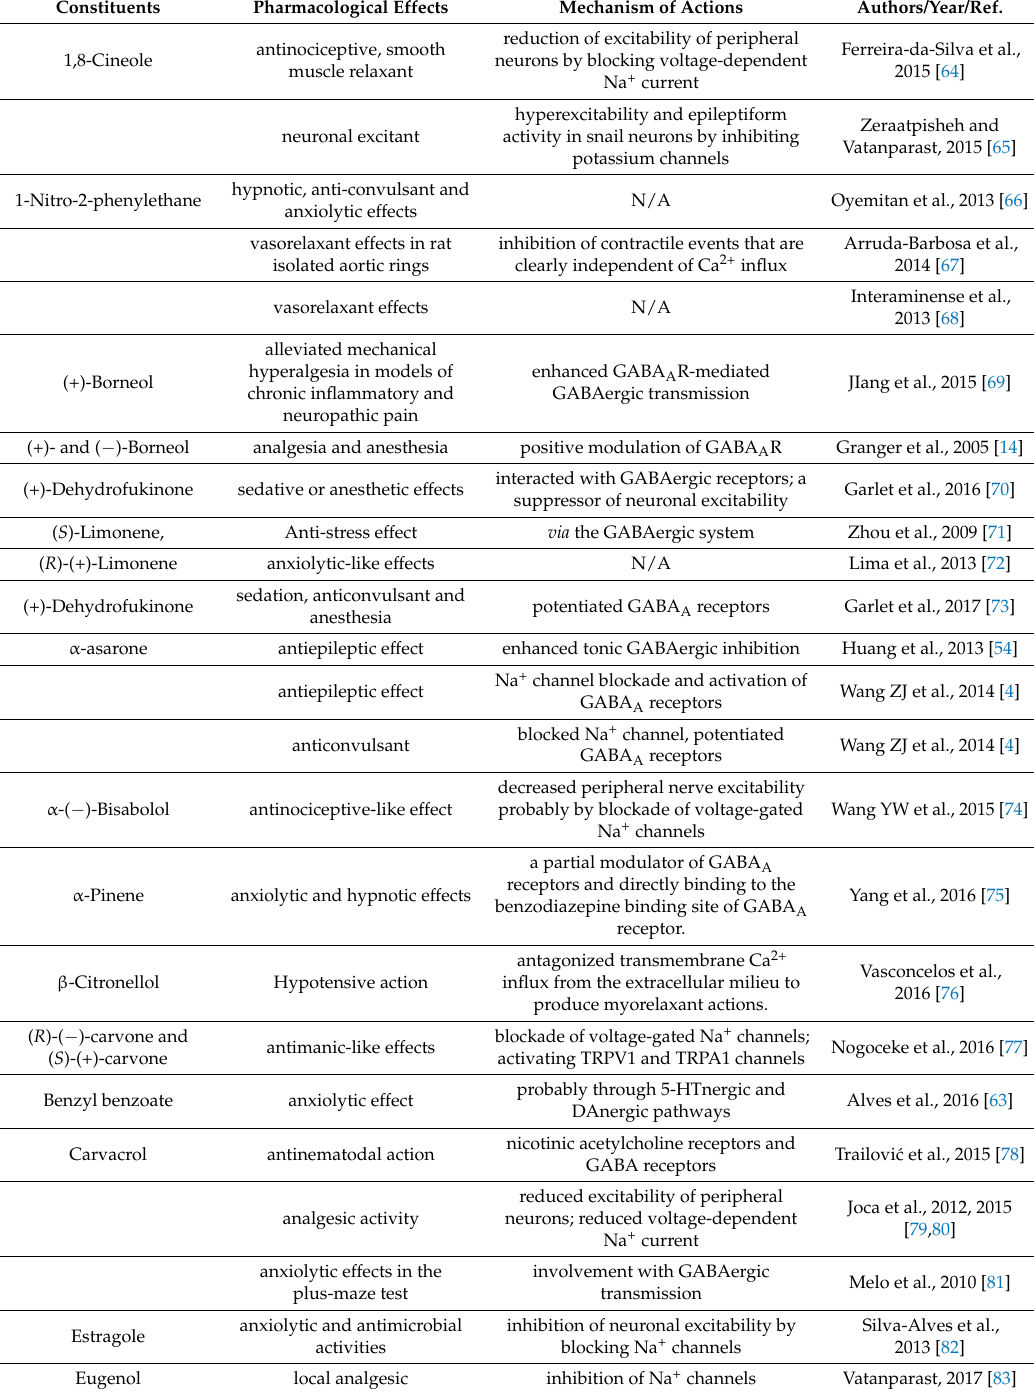
Table 2. The summary of pharmacological properties of constituents from essential oils of different plants targeting Na + channels and GABAergic